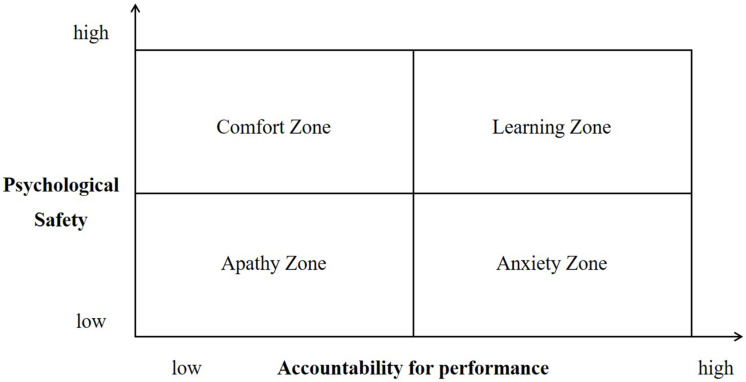
Psychological safety-accountability for performance framework. Source: Edmondson (2012: 174).